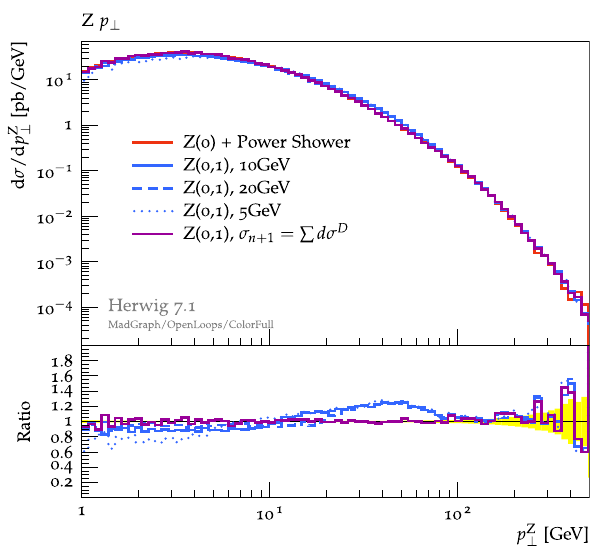
Fig. 6 Z 0 -production: comparing LO plus power shower (red) with a merged sample (blue) and the merged sample where the MEs for the ( Z 0 + 1jet ) sampleshavebeenreplacedbythesumofthecorresponding dipoles